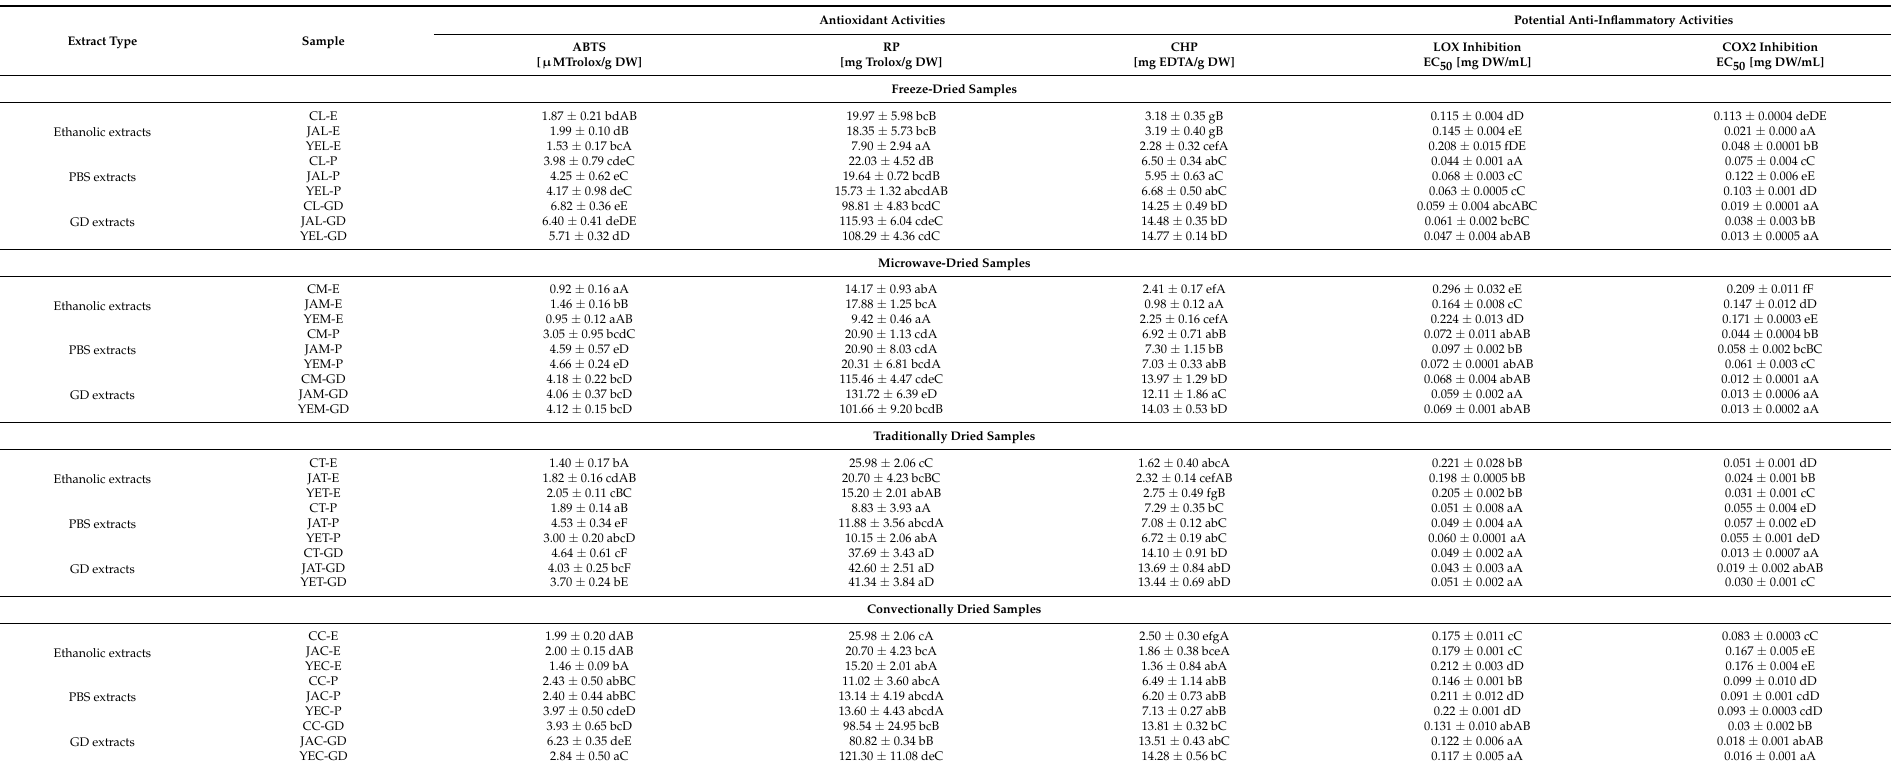
Table 2. The effect of elicitation and drying methods on the antioxidant and potentially anti-inflammatory properties of the ethanolic, buffer (PBS (phosphate buffered saline)), and gastrointestinally digested (GD) extracts from dried lovage